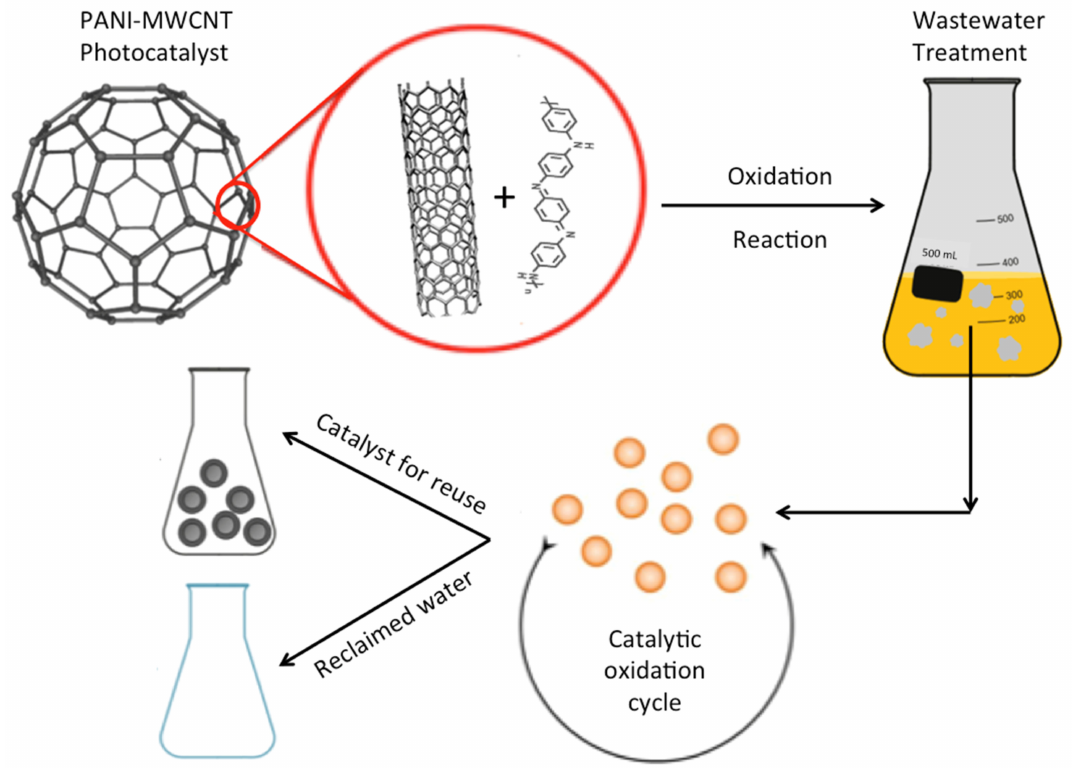
Figure 1. Graphic illustration of the oxidation experimental